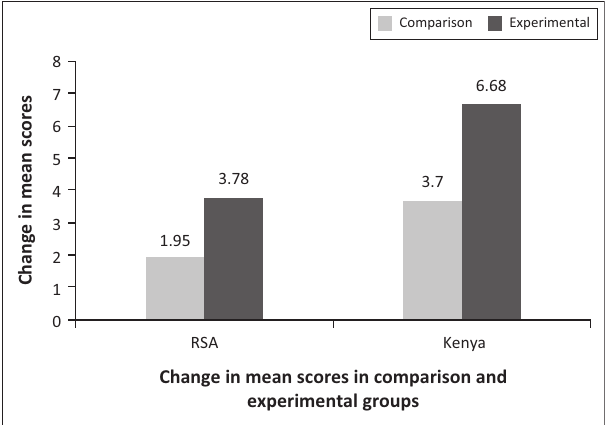
difference between the changes in the pre- and post-test mean scores ( δ x ) and between the experimental and control answered using inferential statistics that include t tests for statistical significance and Cohen’s d as an indicator of